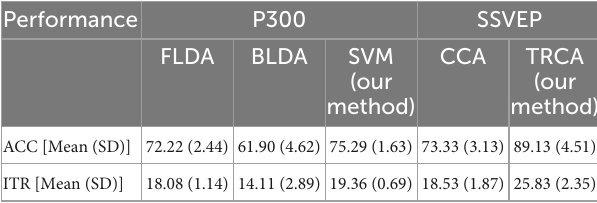
TABLE 3 Performance comparison of the proposed algorithm and its